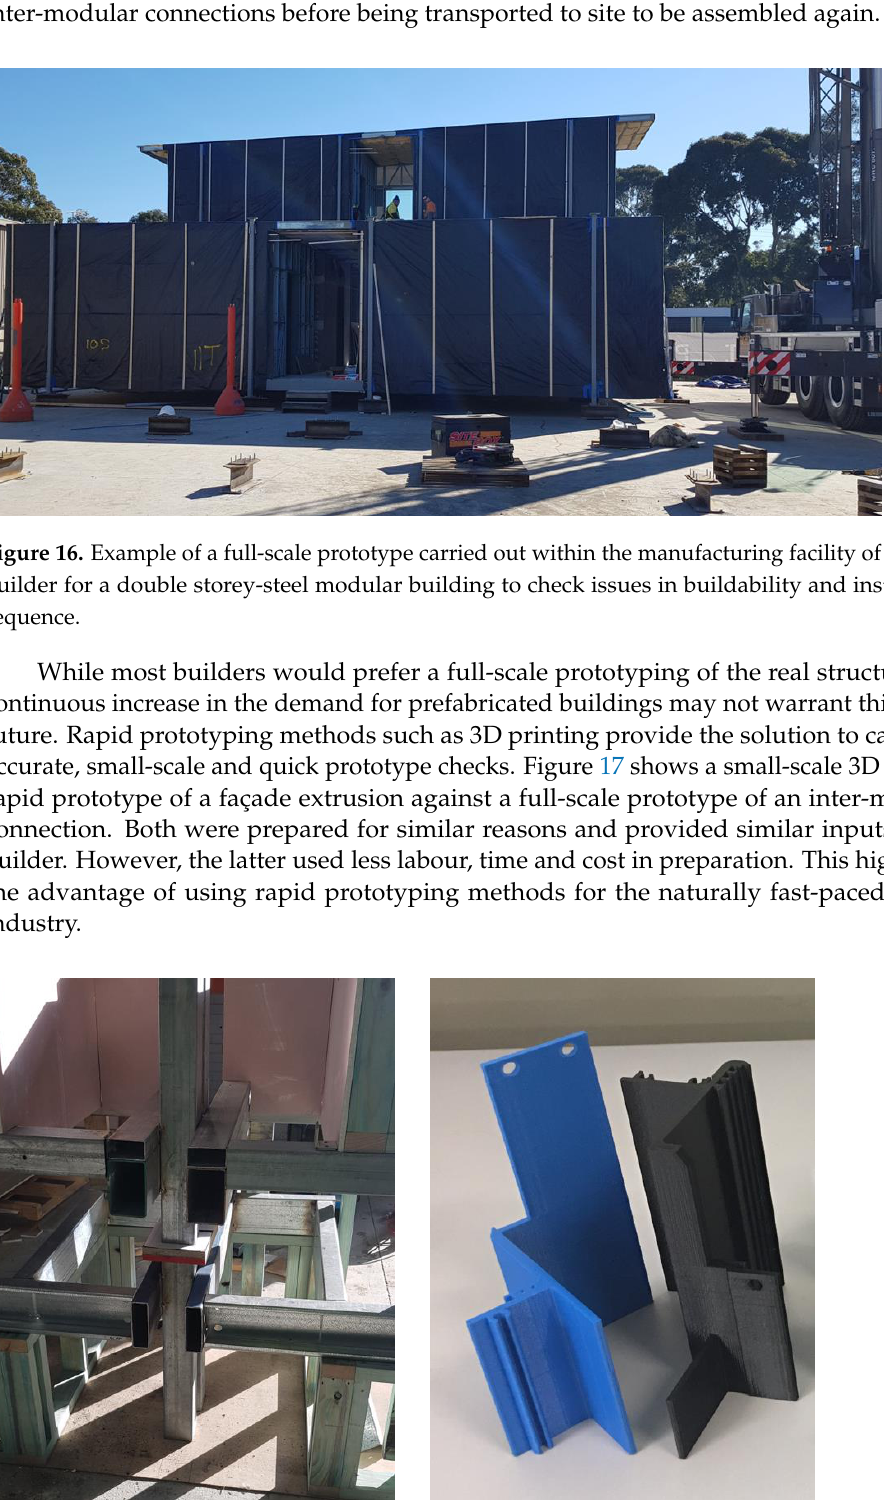
Figure 17. Examples of prototyping for prefabricated structures—A crude prototype with accurate full-scale dimensions of an inter-modular connection to check accessibility to the connection during installation ( left ) and a 3D printed rapid prototype of an extrusion frame of a façade to check buildability and fabrication issues ( right ).